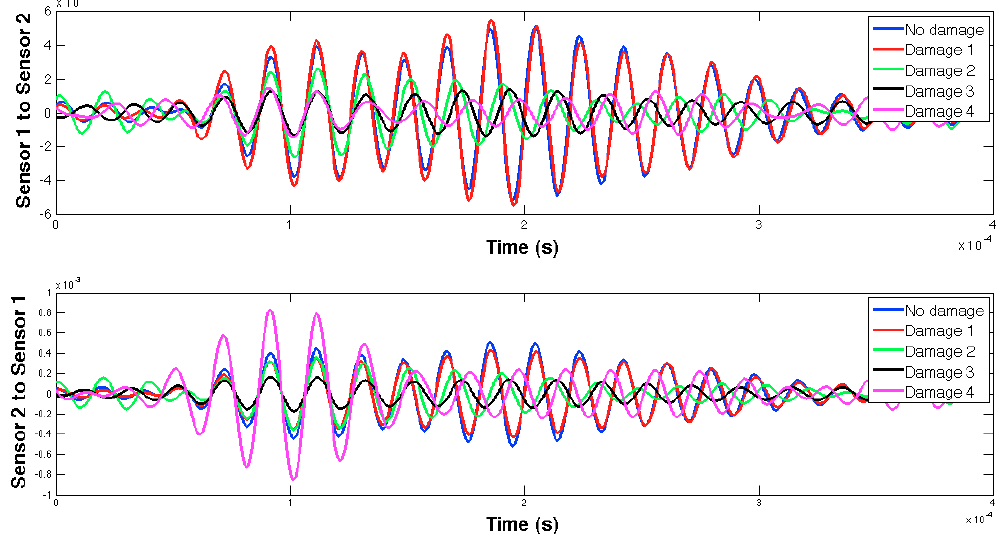
Figure 20. EMPD at 50 kHz. Tone-burst sent and measured between sensors 1 and 2.